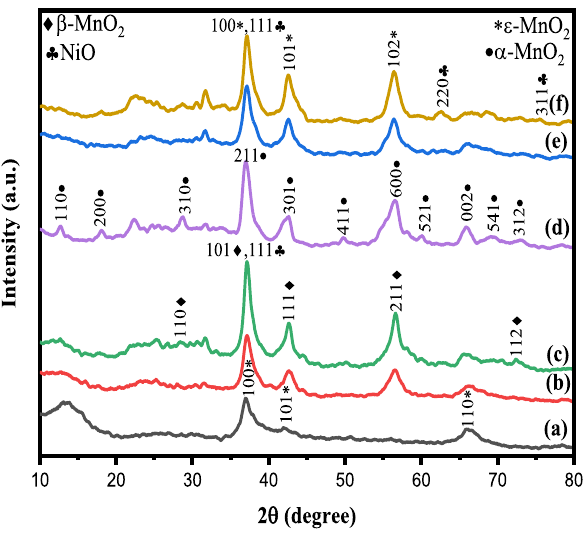
Fig. 2 XRD patterns of (a) MnO (0.05 M), (d) Ni-MnO (0.125 M)